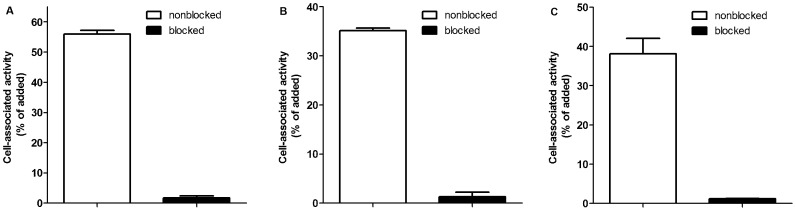
In vitro specificity test of 68Ga-NODAGA-ZHER2:S1 (A), 68Ga-NOTA-ZHER2:S1 (B) and 68Ga-DOTA-ZHER2:S1 (C) binding to HER2 expressing SKOV-3 cells.
Dishes containing cells were incubated with 27 pM radiolabeled conjugated. One group of dishes was pre-saturated with 1000-fold excesses of non-labeled ZHER2:S1 to block the binding site of HER2. Cell-associated radioactivity was calculated as percentage of total added radioactivity. Data are presented as mean values for three cell dishes and standard deviations.